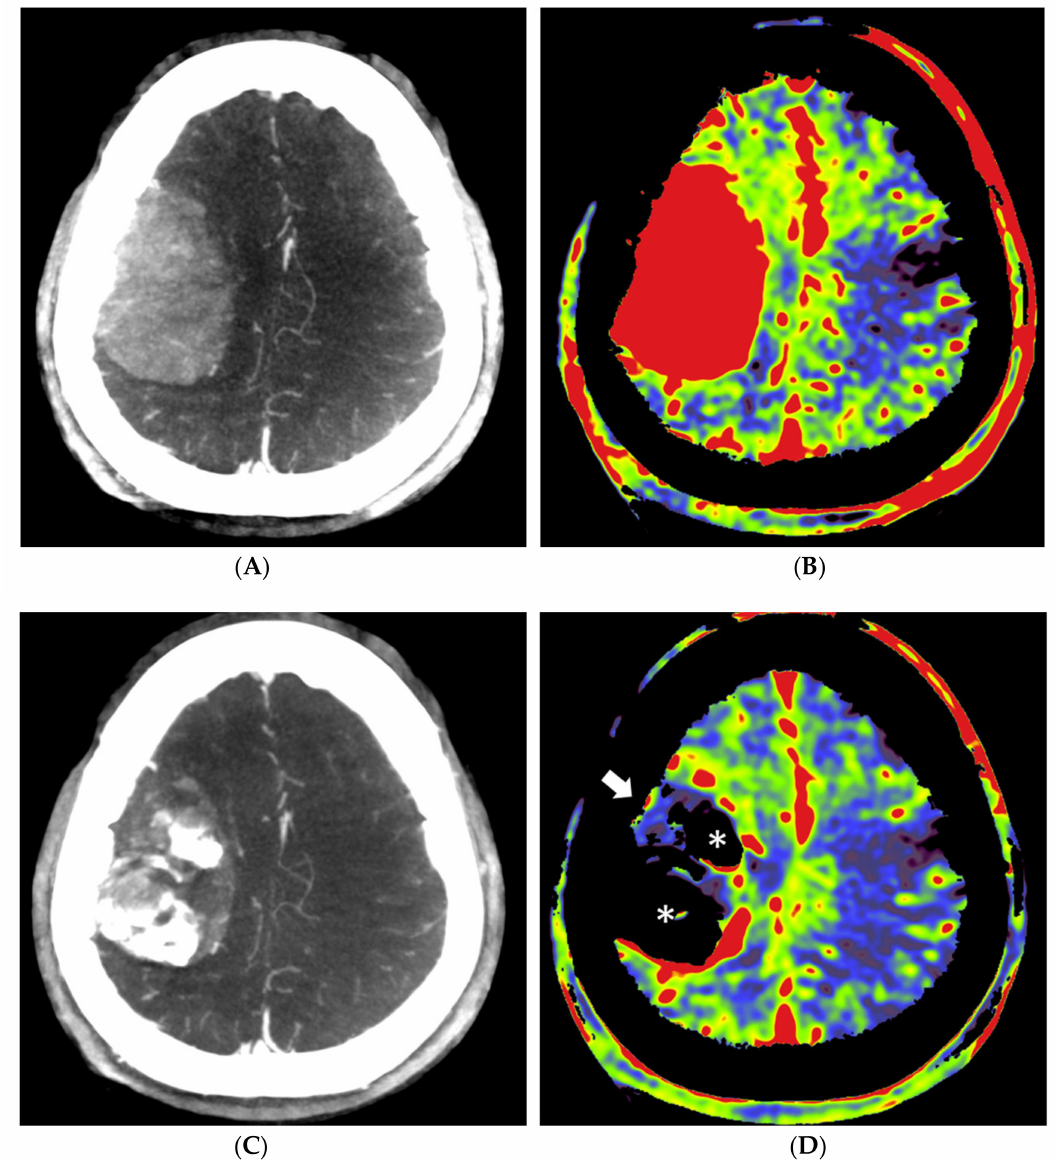
Figure 4. Pre- and post-embolization fill run and PBV mapping of a patient (no. 1) with a large right hemispheric meningioma. ( A ) Pre-embolization axial reformations of fill run and ( B ) whole brain PBV perfusion show dense, homogeneous, hypervascular enhancement of the tumor. ( C ) Post- embolization axial fill run reformation demonstrated tumoral areas with decreased enhancement and large areas with pooled contrast medium. ( D ) The corresponding axial whole brain PBV reformation shows both devascularized (arrows) and blacked-out (*) areas with pooled contrast